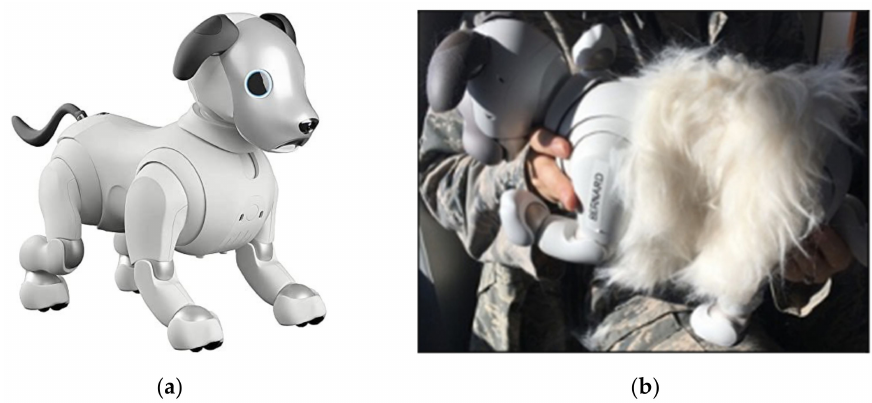
Figure 2. ( a ) Sony Aibo ERS-1000 without the fur; ( b ) Aibo outfitted with a fur